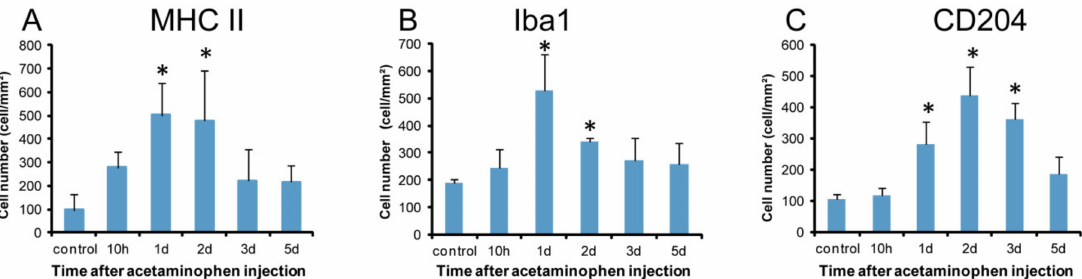
Figure 6. Kinetics of MHC II, Iba1, and CD204 expressing macrophages. Compared to the controls, a significantly increased number of macrophages expressing MHC class II ( A ) on days 1 and 2, Iba1 ( B ) on days 1 and 2, and CD204 ( C ) on days 1–3 are seen. Dunnett’s test; *, significantly di ff erent from controls at p < 0.05. Bar represents mean ±